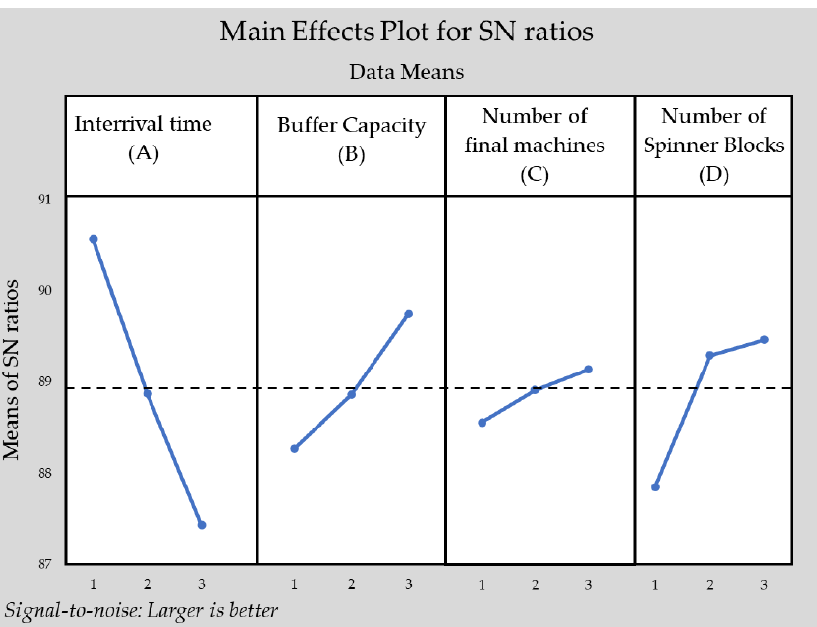
Figure 6. Plot of factor effects.